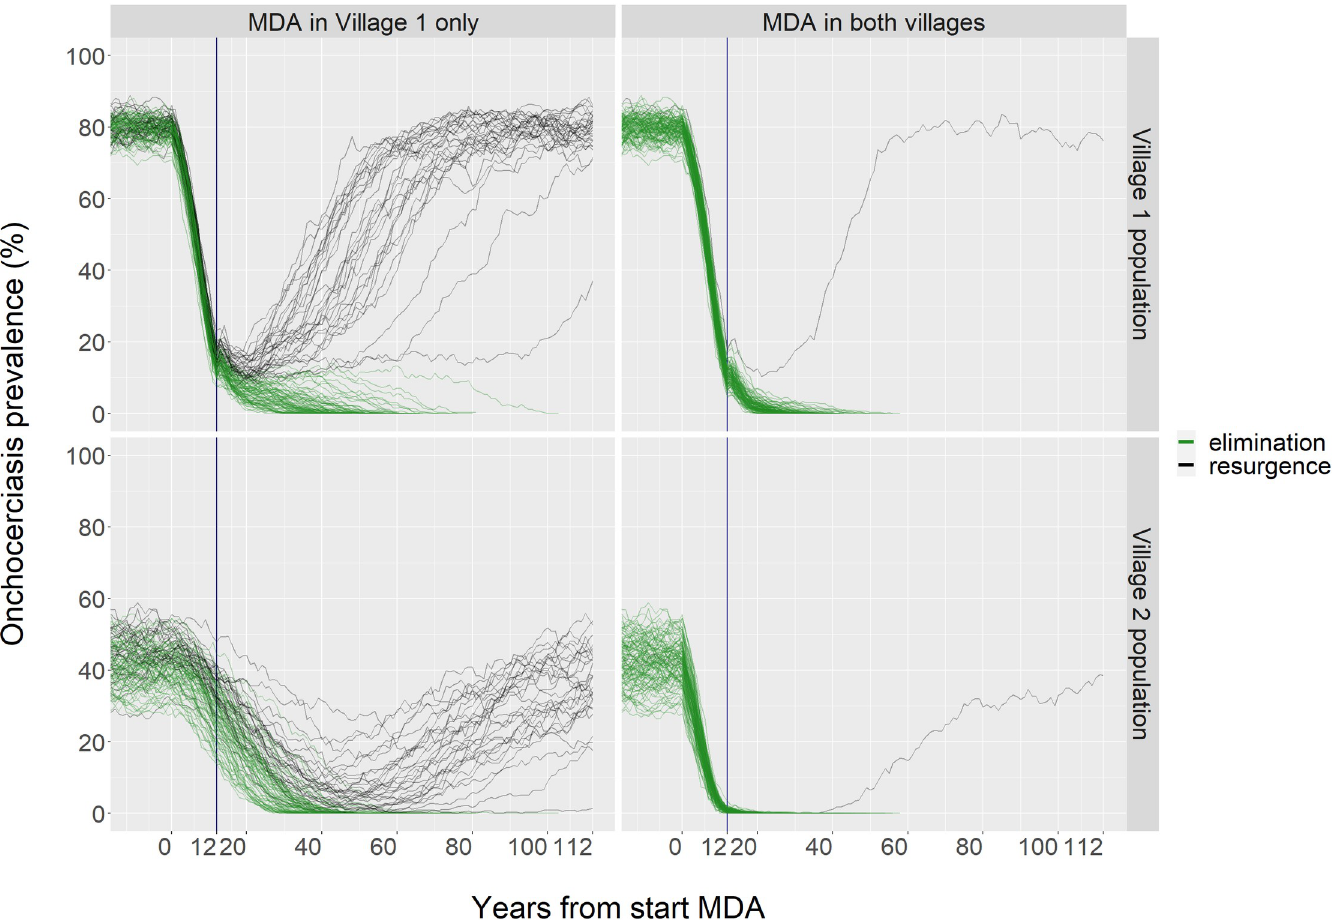
Fig 4. Example of the impact of MDA on prevalence of onchocerciasis in two connected villages. Each line represents one model run. ABR Village 1 = 16,000, ABR Village 2 = 8,000. On average, individuals spend 3% of their time in the other village, assuming symmetrical mixing. MDA duration is 12 years, and is either implemented in both villages or only in Village 1. Each run is continued for 100 years post MDA, at which timepoint it is determined whether either onchocerciasis prevalence is eliminated (0.0%) or whether resurgence of prevalence has occurred. With MDA in both villages, resurgence occurs in just 1 out of 100 runs, while with MDA in Village 1 only, resurgence occurs in 30 of the 100 runs. With MDA implemented in just the source location (Village 1), resurgence is to a large extent determined by the onchocerciasis prevalence in the spill-over prevalence location (Village 2) at the end of MDA; for those 30 runs showing resurgence, the mean prevalence in Village 2 at the end of MDA (vertical lines at 12 years) is 35% (range 21%-48%), while it is on average 28% (14%-44%) among the 70 runs showing eventual elimination. Prevalence is among those aged 5+ years.